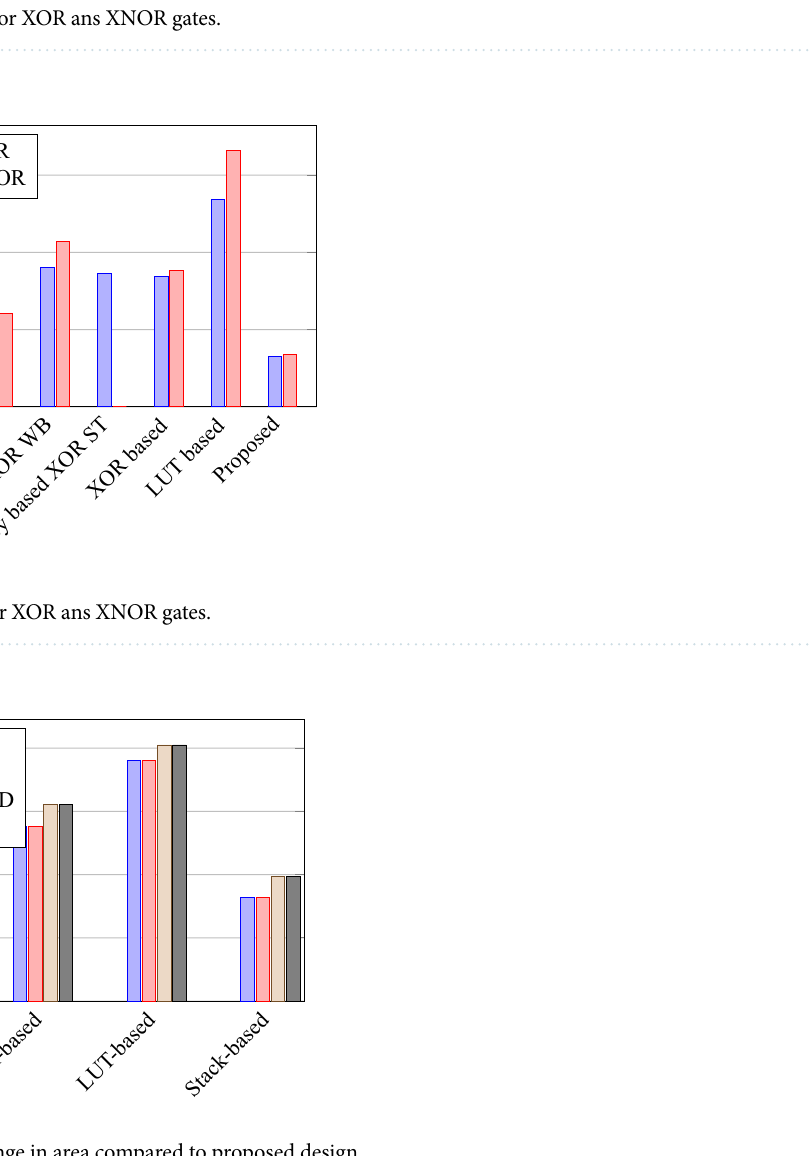
Figure 37. Delay for XOR ans XNOR gates.